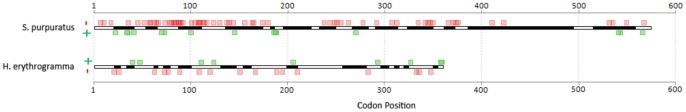
A comparison of codon diversification between S. purpuratus and H. erythrogramma 185/333 cDNA alignments.Sequence alignments of 231 S. purpuratus and 112 H. erythrogramma cDNAs were used to investigate recombination and selective pressure at the codon level. Element patterns are shown as black and white banding, while positively- and negatively-selected codons are shown as green and red boxes above and below each alignment, respectively. Negative selection (against codon diversification) appears to be prevalent across 185/333 sequences from both species. Significant (p<0.1) negative selection was detected in 64 codons across the 581 codon-long S. purpuratus alignment, while 15 codons were positively-selected. The 360 codon-long H. erythrogramma alignment contained 17 codons under significant negative selective pressure and nine codons with positive selective pressure. S. purpuratus element patterns adapted from [16].